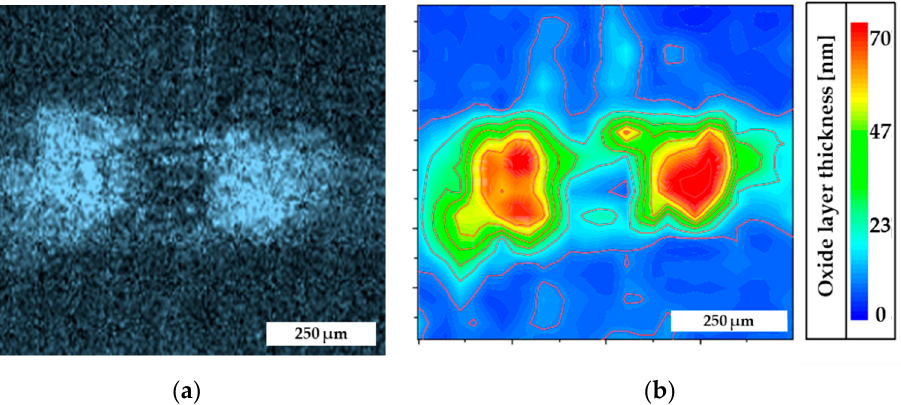
Figure 11. Chemical analysis of the wear zone of a tinned electrical contact after a vibration and temperature cycling test: ( a ) Qualitative EDS mapping of oxide (acceleration voltage 15 keV); ( b ) Quantitative WDS mapping of oxide with determination of geometric layer thickness (acceleration voltage 8 keV).